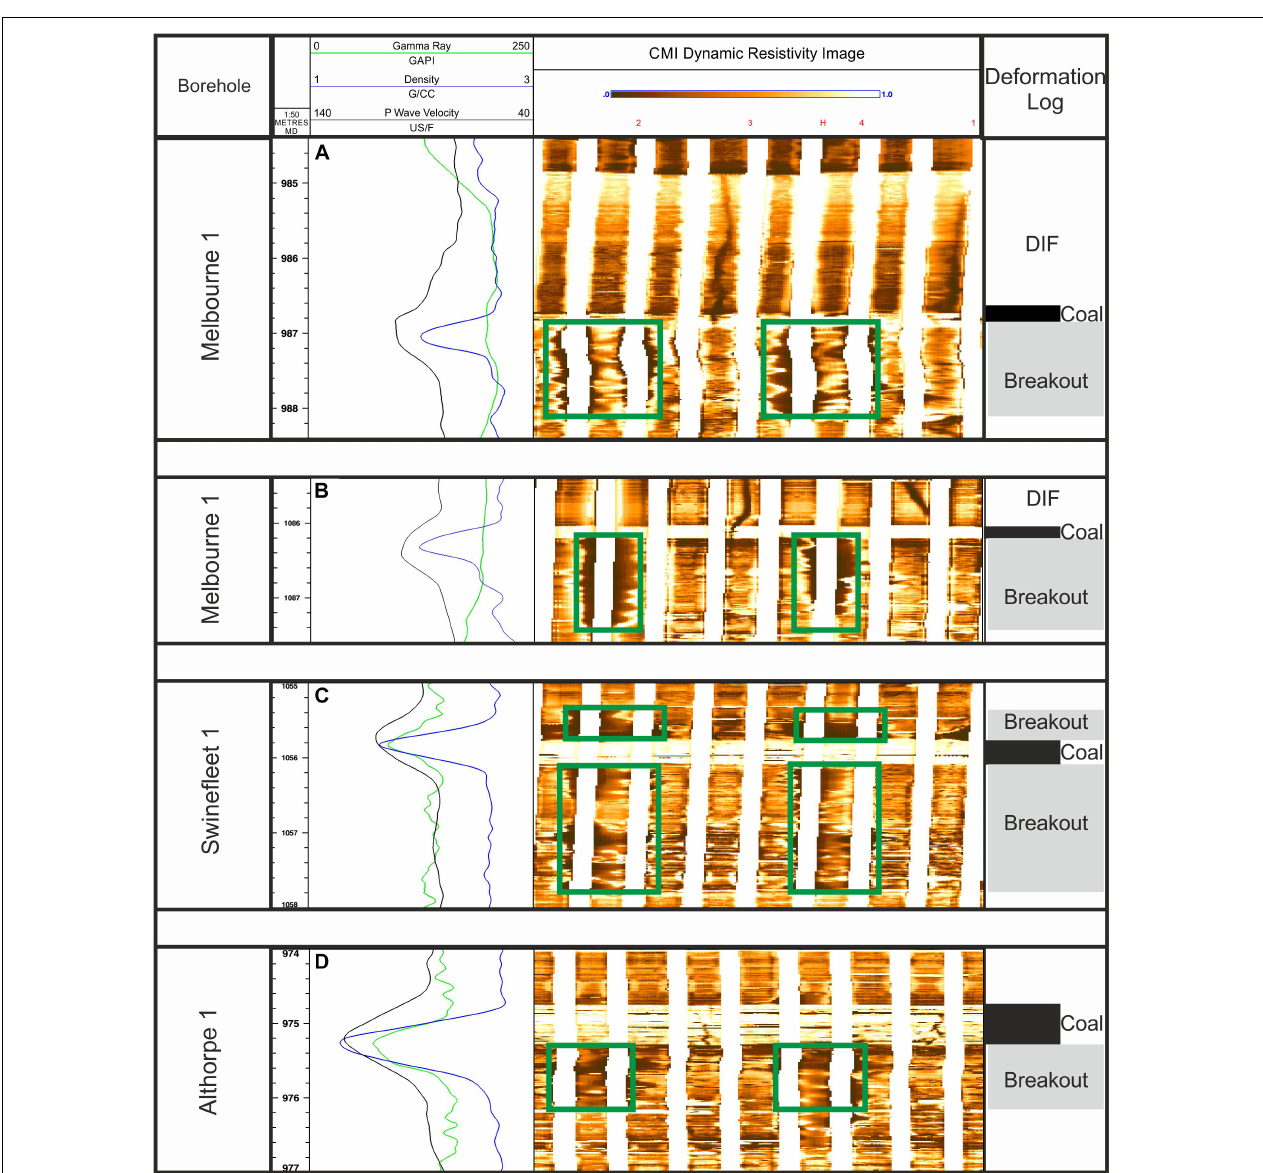
FIGURE 2 | Plot showing breakout occurrence beneath coal seams. (A) Section from Melbourne 1, 984.4 m – 988.4 m. (B) Section from Melbourne 1, 1086.4 m – 1087.6 m. (C) Section from Swinefleet 1, 1055 m – 1058 m. (D) Section from the Althorpe 1, 974 m – 977 m. Left panel, wireline logs including Sonic Transit Time and Gamma Ray. Center Panel, Unwrapped Compact Micro Imager (CMI) resistivity image (clockwise from North) and breakouts highlighted by green boxes. Right Panel, Deformation log showing breakouts and DIFs, Coal Seams marked by black rectangles.